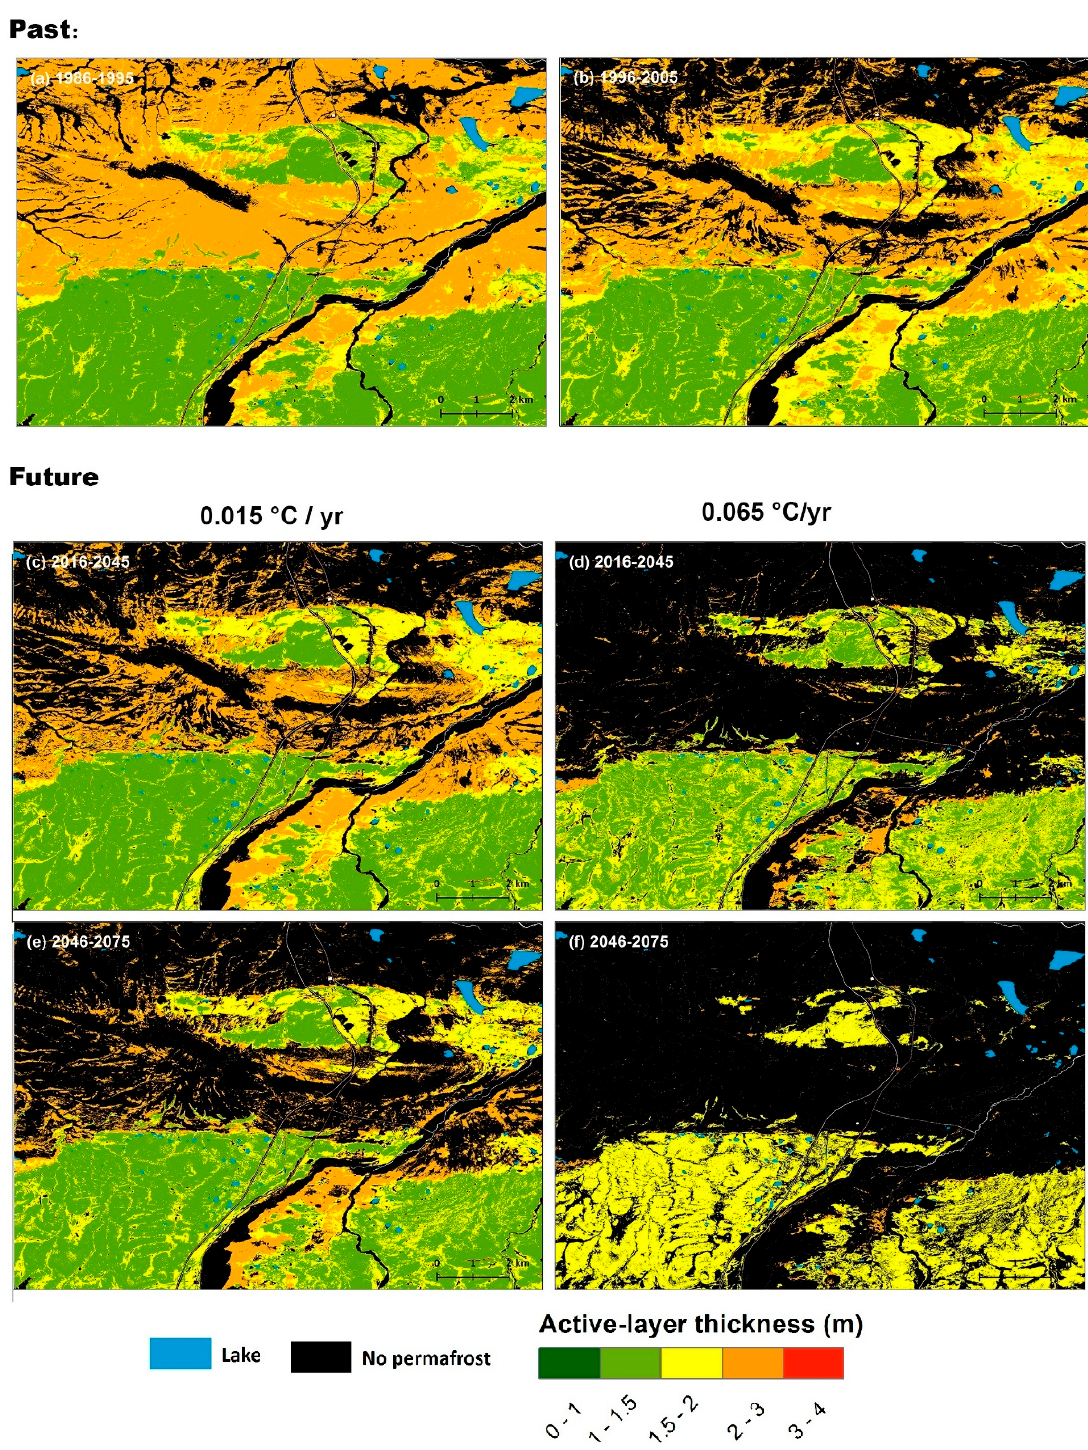
Figure 9. Modeled evolution of the active-layer thickness. ( a ) 1986–1995, ( b ) 1996–2005, ( c , d ) 2016–2045 for the low- and high-rate runs, ( e , f ) 2046–2075 for the low- and high-rate runs.